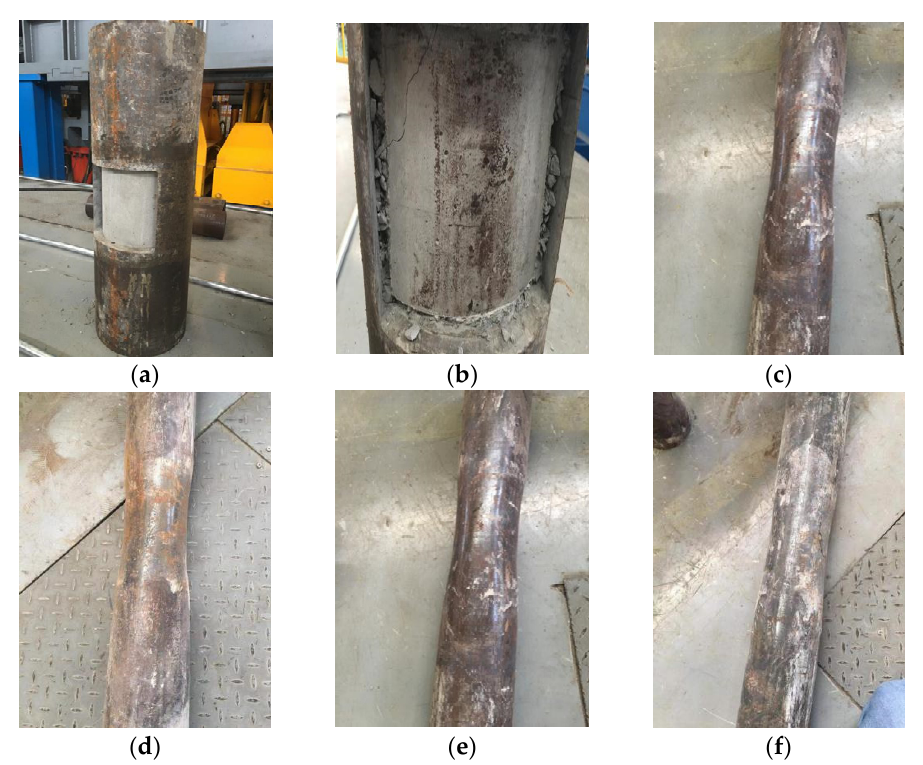
Figure 12. Casing morphology after cement-sheath casing extrusion test: ( a ) before cement-sheath casing extrusion; ( b ) after cement-sheath casing extrusion; ( c ) #1 cement-sheath casing after extrusion; ( d ) #2 cement-sheath casing; ( e ) #3 cement-sheath casing; ( f ) 125 ksi cement-sheath casing.